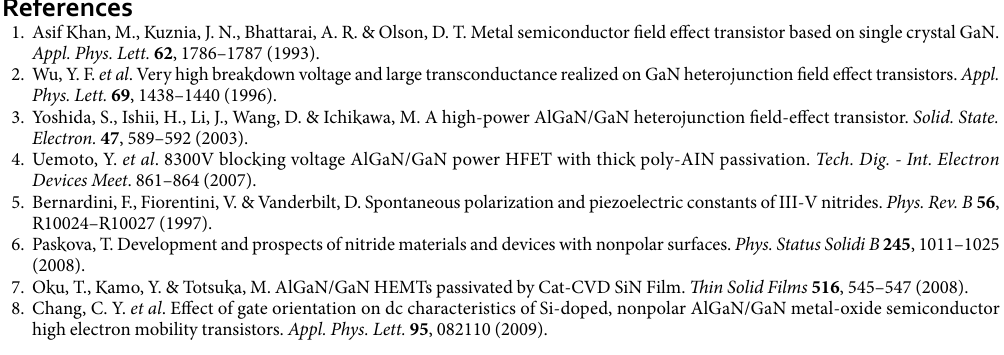
GaN on our regularly arrayed micro-rod template shows an isotropic in-plane distribution. Between them is the overgrown sample on the standard stripe-patterned template. Methods Fabrication of patterned templates.